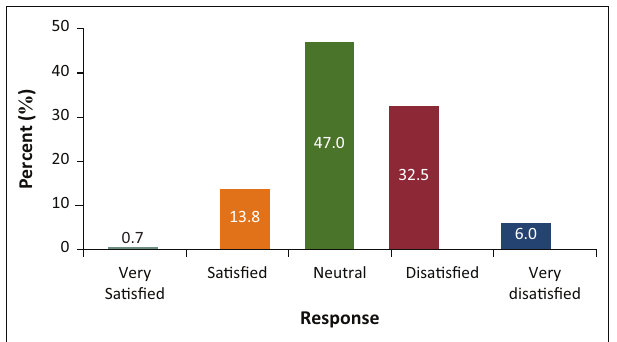
FIGURE 1: Overall participant’s responses regarding the impact of talent management on job satisfaction.